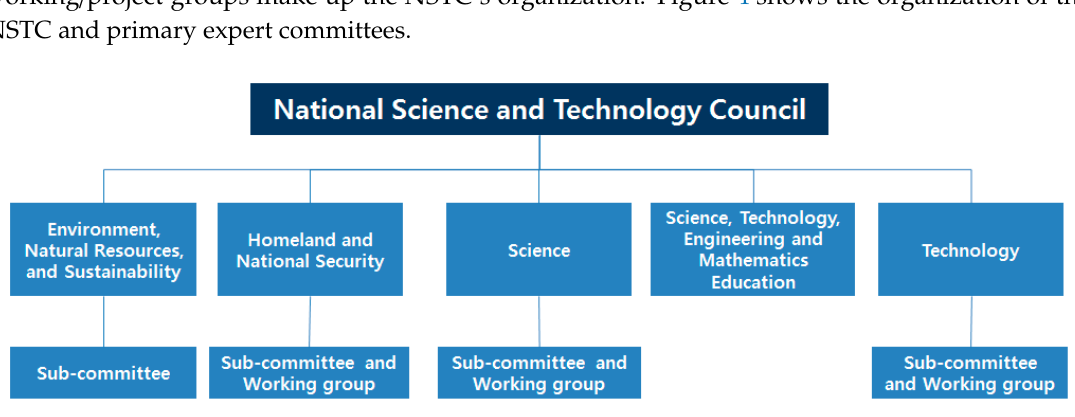
Figure 4. Organization of the NSTC in the U.S.